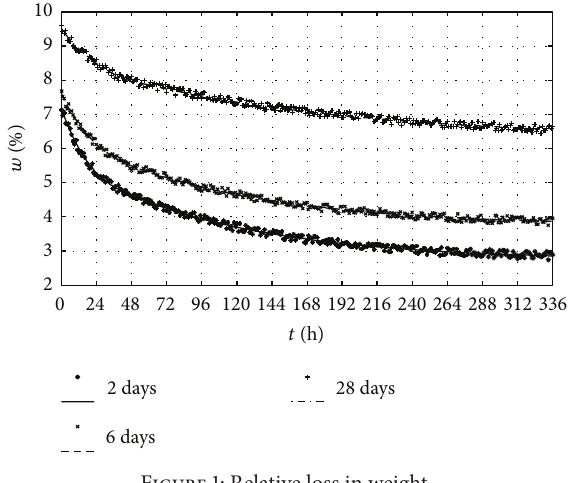
Figure 1: Relative loss in